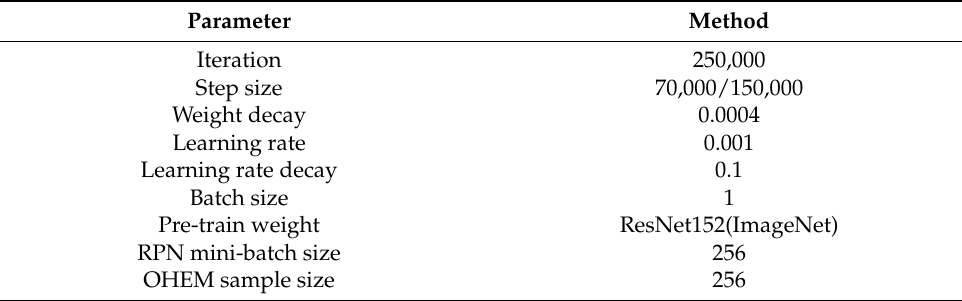
Table 4. Training Parameters of Faster R-CNN [26].